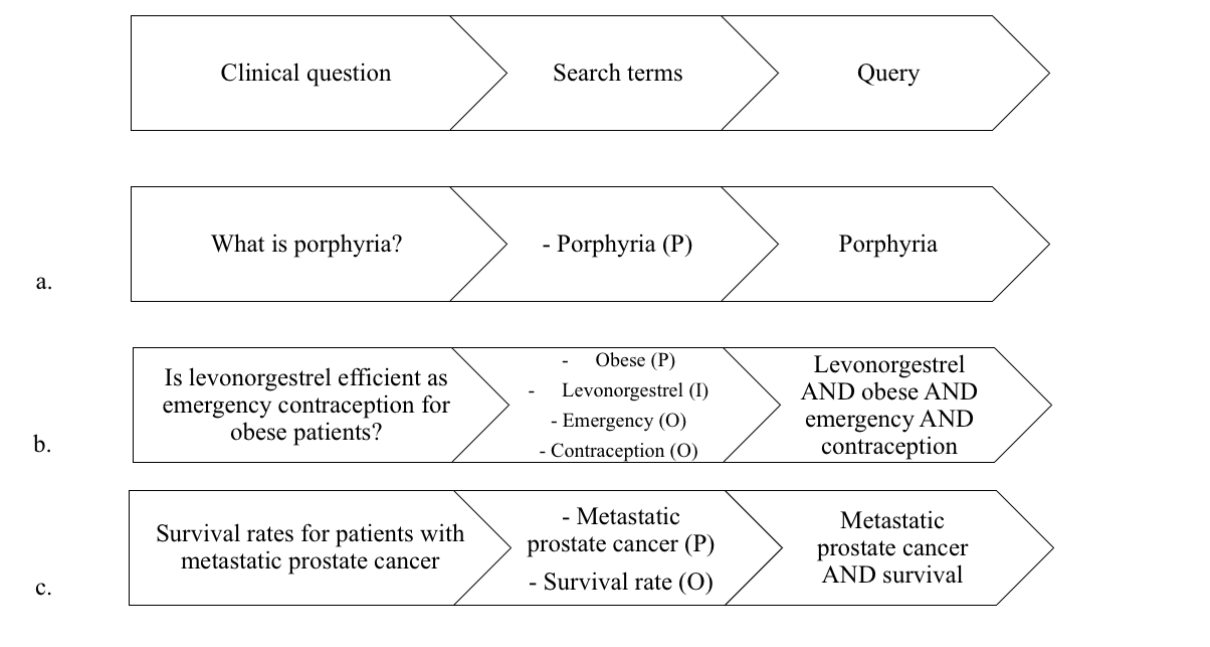
Figure 1. The path from a clinical question to a query using the population (P), intervention (I), comparison (C), and outcome (O) (PICO) framework. Examples are shown for (a) a background question, (b) a foreground therapy question, and (c) a foreground prognosis